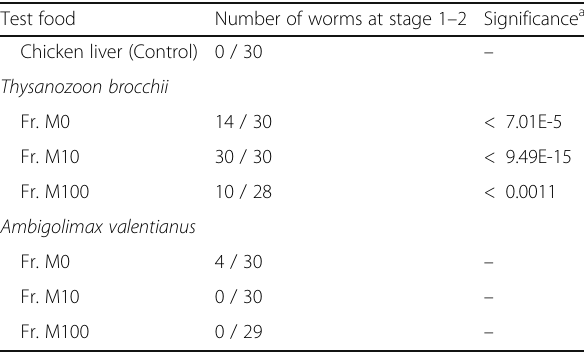
Table 3 The ovary-inducing activity in the cytosolic fractions from Thysanozoon brocchii and Ambigolimax valentianus Test food Number of worms at stage 1 – 2 Significance a Chicken liver (Control) 0 /